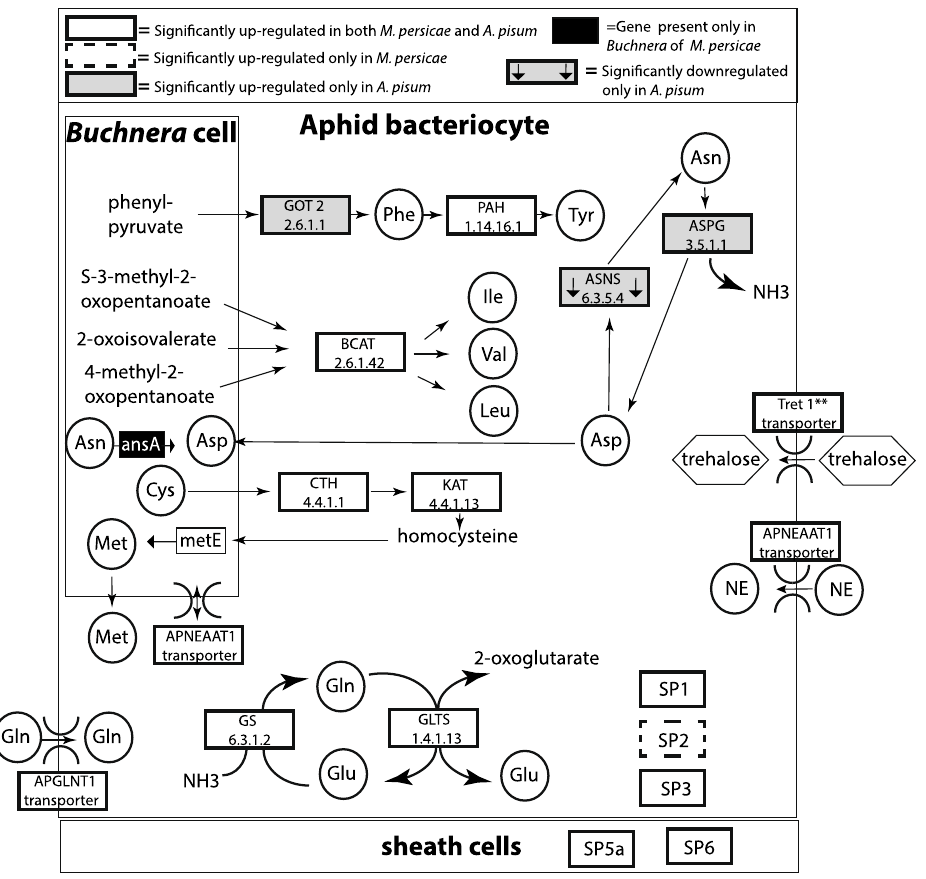
Figure 1. Gene expression of aphid genes involved in the integrative metabolism with Buchnera . ** indicates four homologs significantly up-regulated in both M. persicae and A. pisum